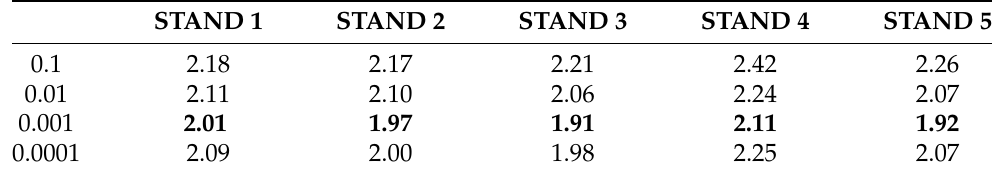
Table 3. Experimental results with various learning rates for the roll force prediction models. (The number of hidden layers: 1. The number of hidden nodes: 700. Activation function: ReLU.)